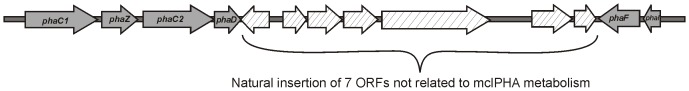
Genetic organization of the mclPHA gene cluster in P. extremaustralis.
mclPHA genes belonging to γ Proteobacteria (smooth arrows). Natural insertion containing 7 ORFs related to β Proteobacteria between the genes phaD and phaF (broken arrows). Arrows indicate the direction of gene transcription and the relative size of each ORF. From left to right: phaC1(1680 bp), phaZ (846 bp), phaC2 (1683 bp), phaD (621 bp), followed by genes encoding a LuxR family DNA binding response regulator (642 bp), a putative fimbrial subunit (579 bp), a bacterial pili assembly chaperone (780 bp), a pili assembly chaperone (759 bp), an outer membrane usher protein FimD (2505 bp), a putative fimbrial protein (945 bp) and a Pi fimbriae major subunit (528 bp), not related to PHA metabolism, and phaF (927 bp) and phaI (423 bp).